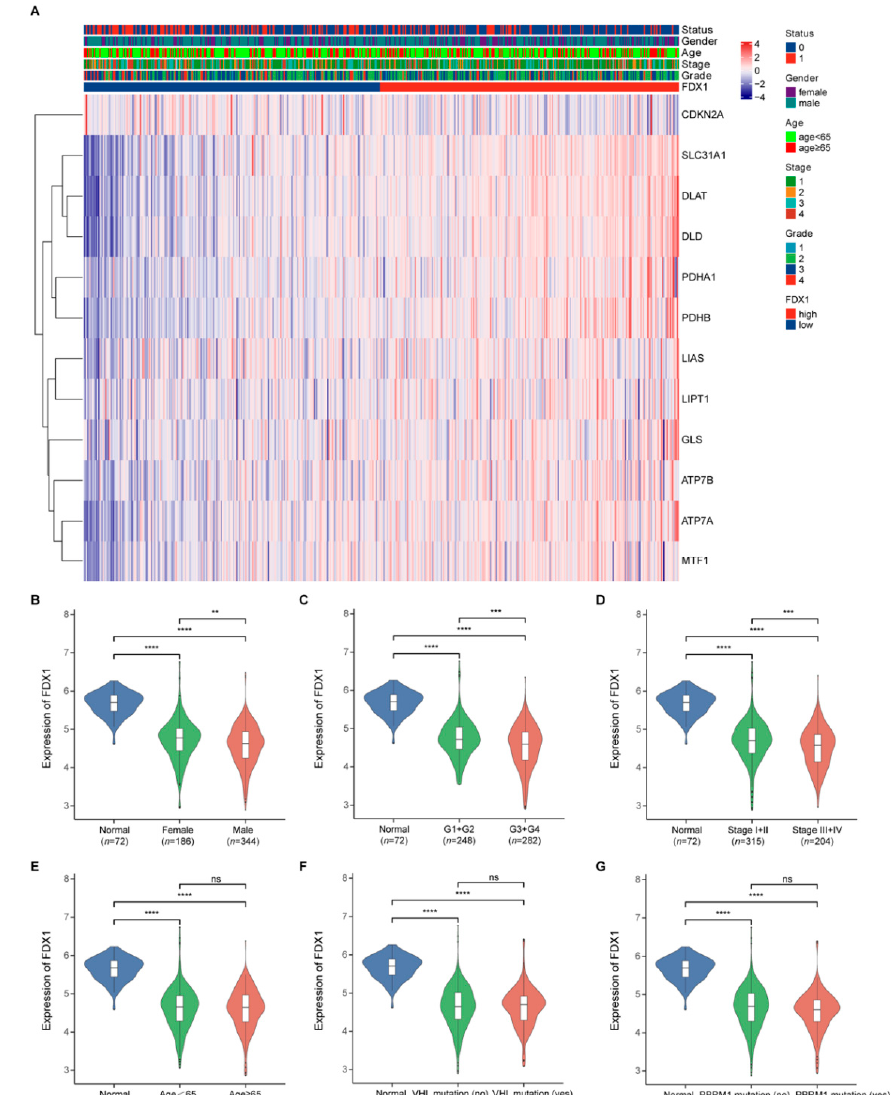
Figure 3. FDX1 expression in different subgroup ccRCC patients. ( A ) The correlation between the FDX1 expression and the clinical features; ( B – G ) FDX1 expression in ccRCC patients according to different clinical characteristics. p values less than 0.05 were considered to be statistically significant. ** p < 0.01, *** p < 0.001, **** p < 0.0001.